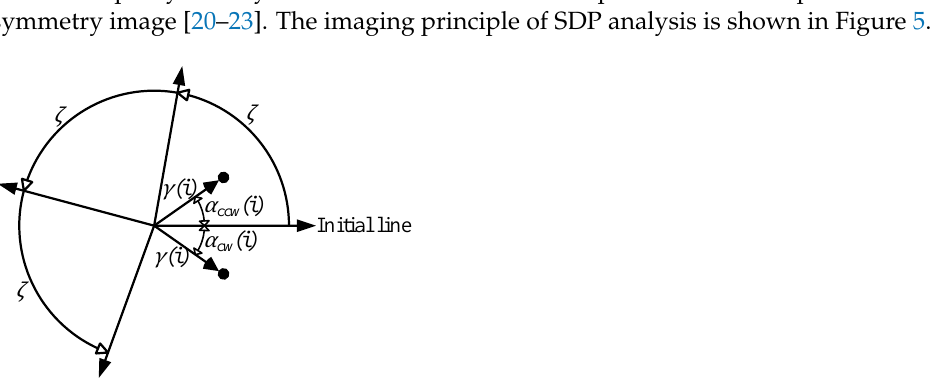
Figure 5. Image principle of SDP analysis.